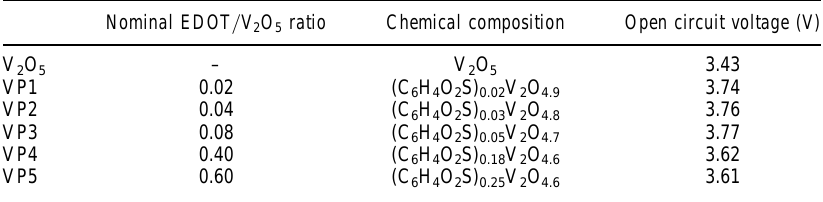
TABLE V Nominal EDOT = V 2 O 5 Ratio, Corresponding Chemical Composition and Open Circuit Voltage vs. Li þ = Li for the Pristine V 2 O 5 and Hybrid